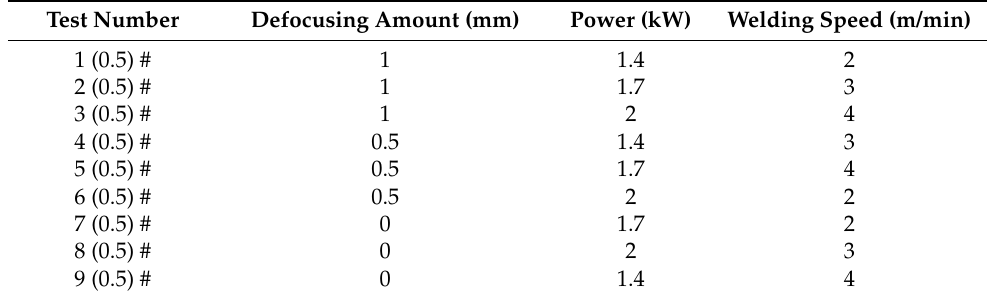
Table 3. Three-factor and three-level (L8 (33)) orthogonal test schemes for laser welding of Mo–5Re sheets with a thickness of 0.5